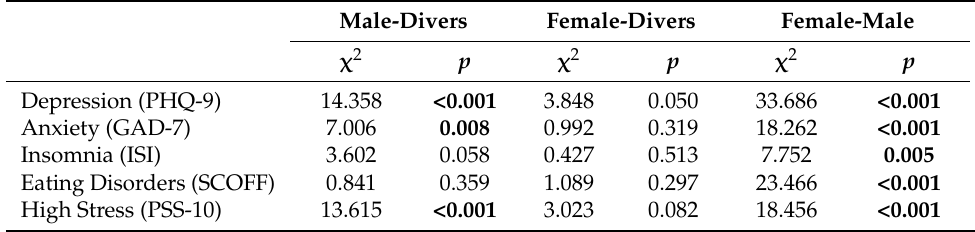
Table 2. Post hoc pairwise gender comparisons of the mental health